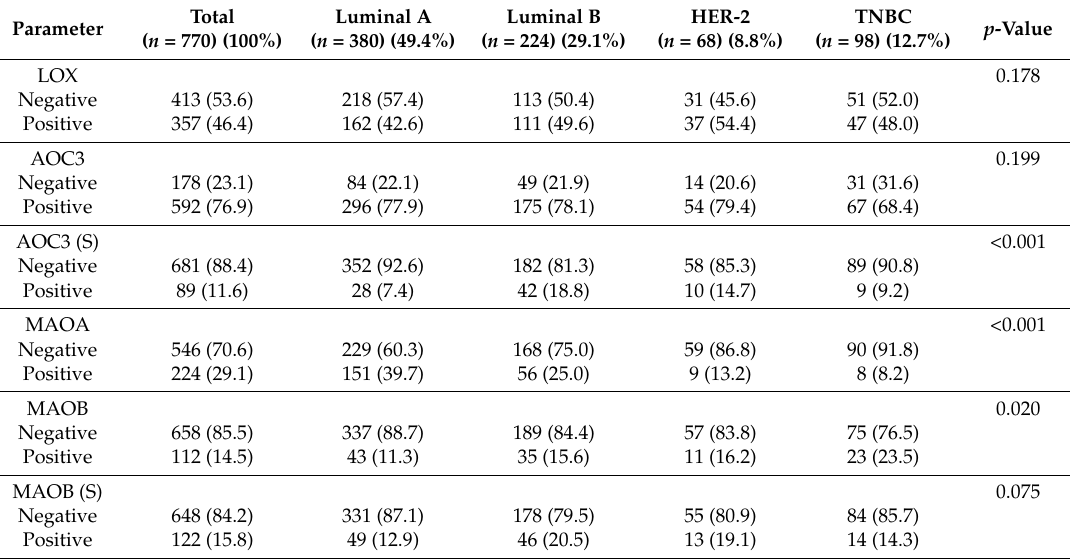
Table 2. Expression of the amine oxidase according to breast cancer subtypes.